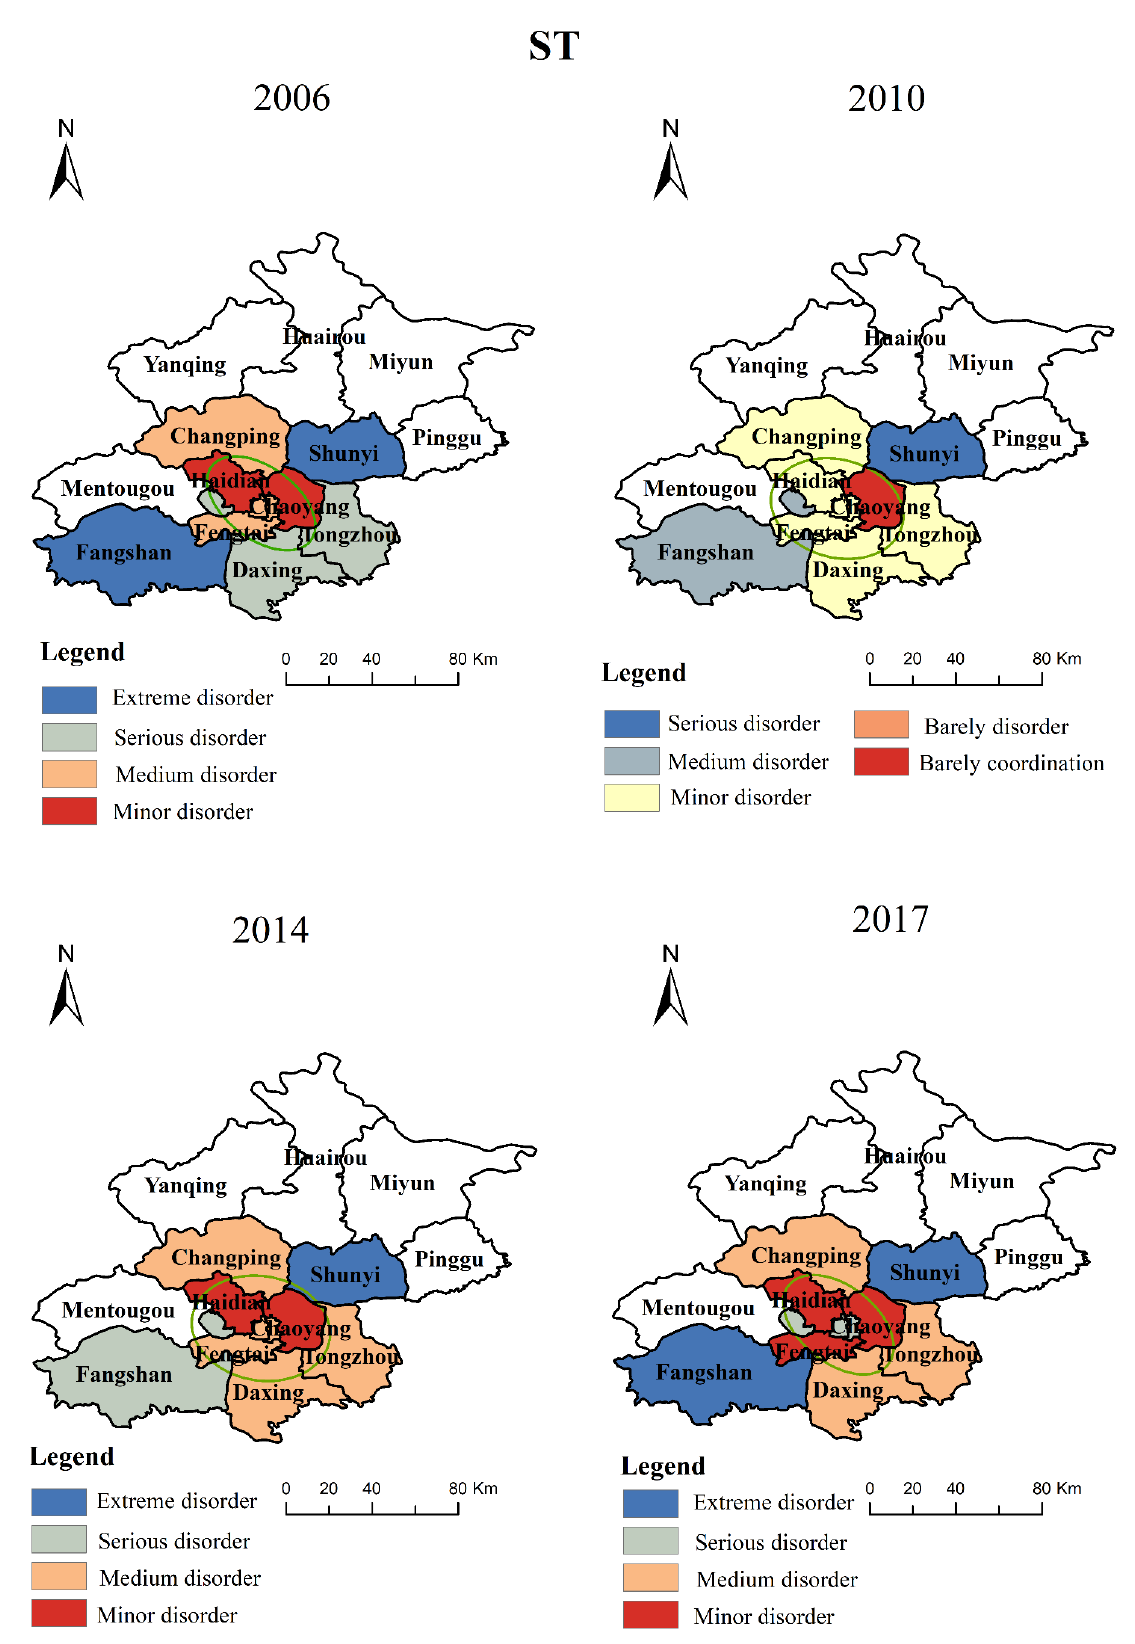
Figure 4. The spatiotemporal distributions of pairwise coupling coordination degree in different regions.